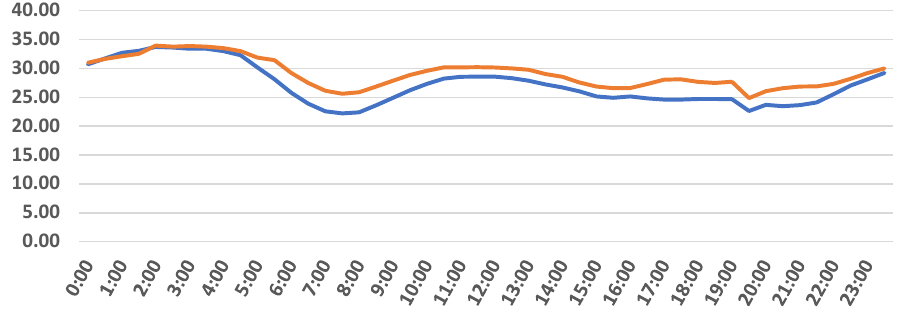
Figure 3. The weighted daily average price for upwards and downwards LFAS in the WEM.